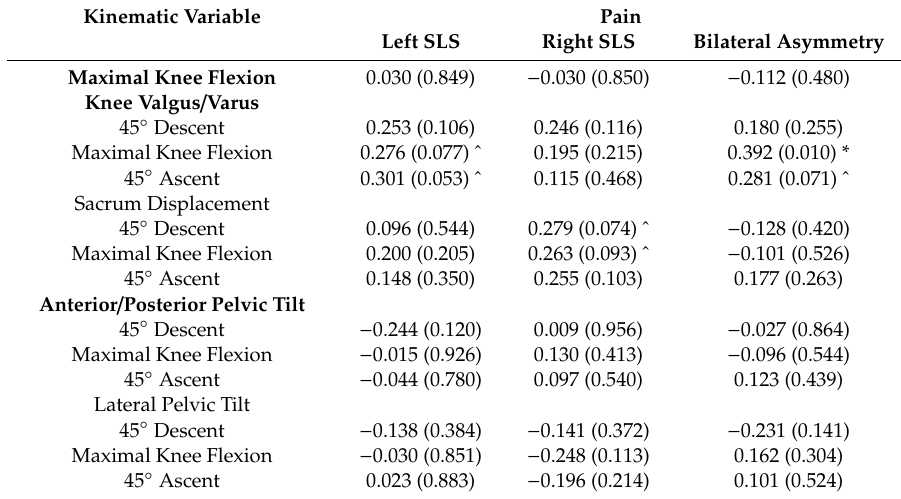
Table 2. Pearson Point Biserial Correlations between Pain and Z -scores of Kinematic Data at Each Single-Leg Squat (SLS)